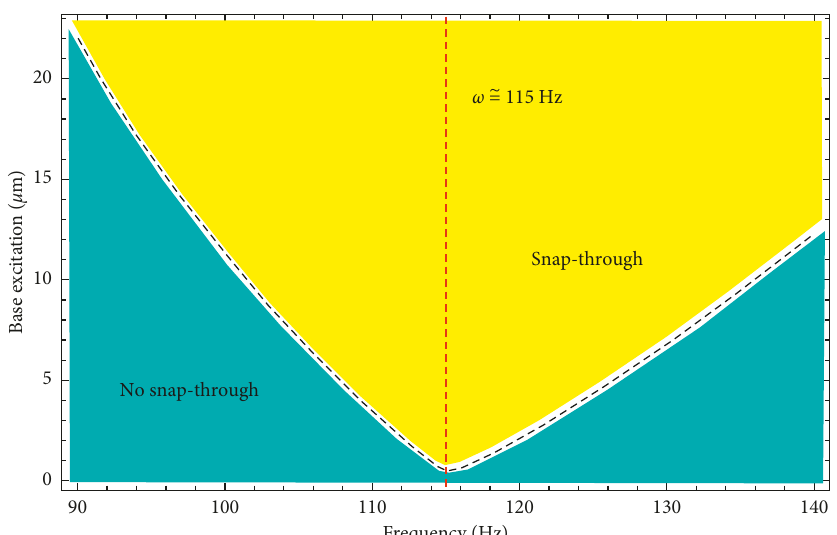
Figure 6: Variation of required base amplitude for the snap-through motion versus exciting